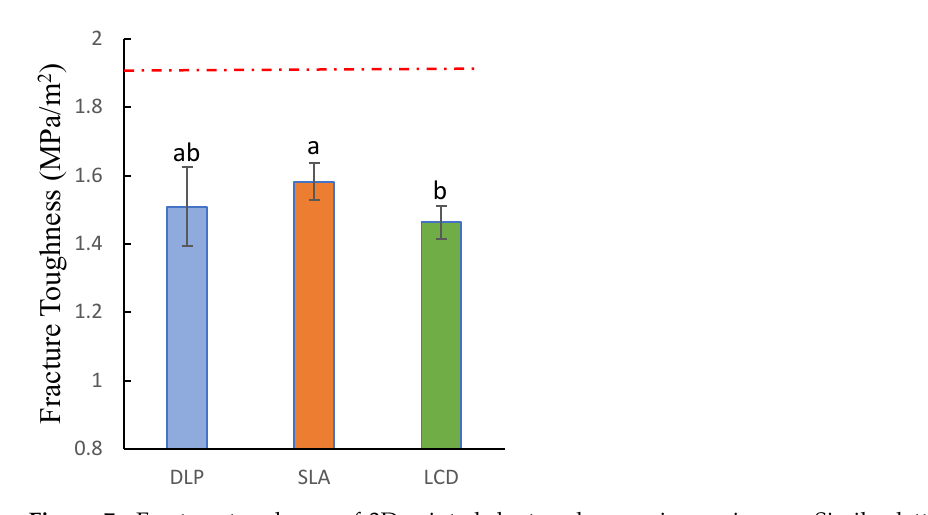
Figure 7. Fracture toughness of 3D-printed denture base resin specimens. Similar letters indicate insignificant differences. Red dotted line indicated the minimum requirement according to ISO standards.